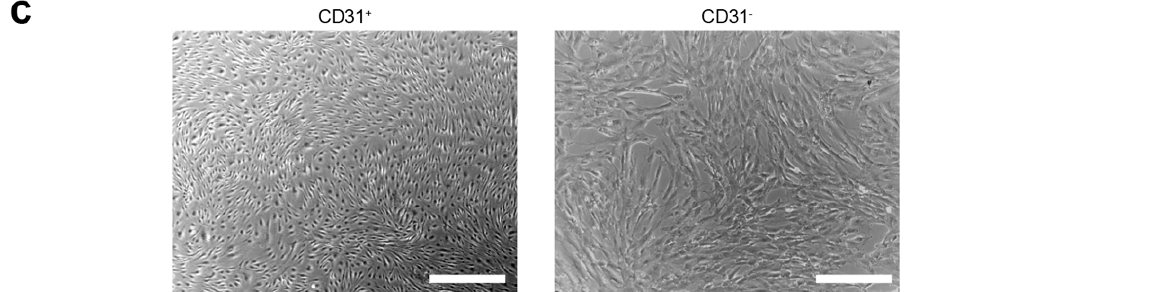
Figure 1. Generation of endothelial cells (ECs) and pericytes from keratinocyte-derived human induced pluripotent stem cells. ( a ). Schematic representation of the embryoid body based differentiation protocol. ( b ). Bright-field images of critical stages of differentiation: hiPSC aggregates formed at day 0 (D0), cell aggregates after mesoderm induction (D3), attached colonies at the day 6 (D6), differentiated cells before cell sorting (D10); scale bars: 500 µm. ( c ). Bright-field images that show the morphology of sorted ECs (CD31 + ) and pericytes (CD31 − ); scale bars: 500 µm.